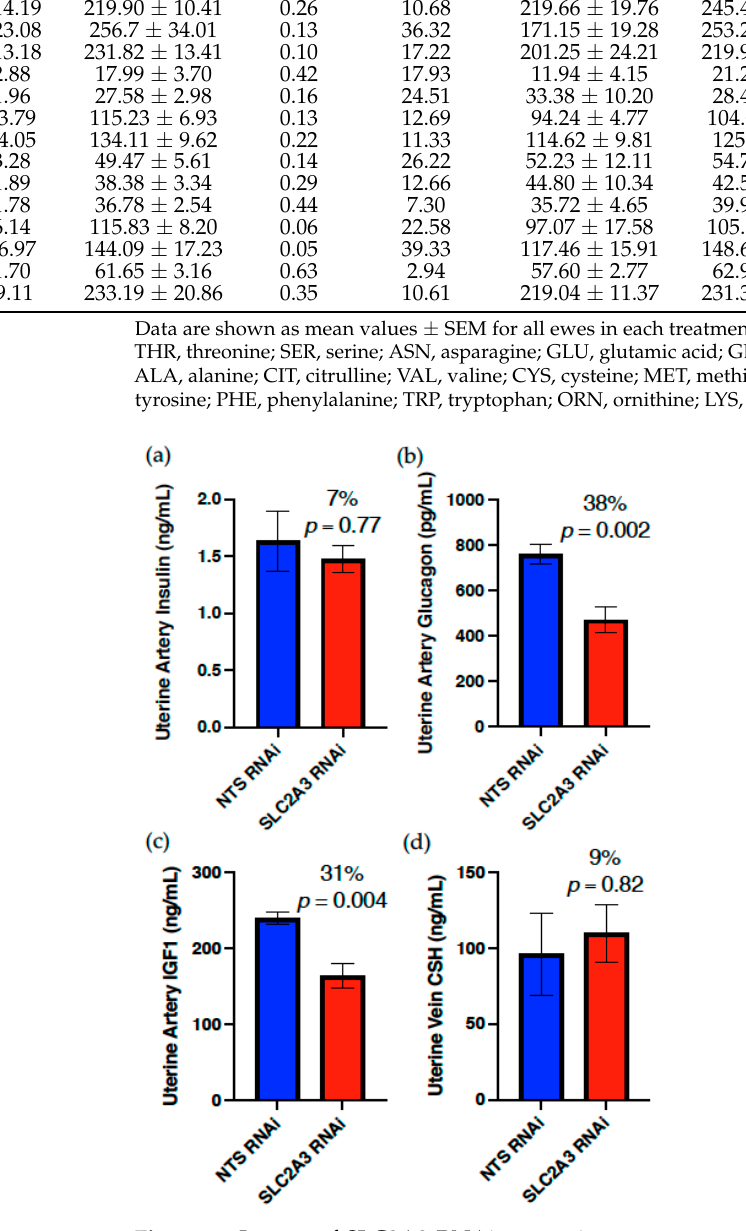
Figure 5. Impact of SLC2A3 RNAi on uterine artery concentrations of ( a ) insulin, ( b ) glucagon and ( c ) IGF1, and ( d ) uterine vein concentrations of CSH. Data are shown as means ± SEM. NTS, non-targeting sequence; RNAi, RNA interference.